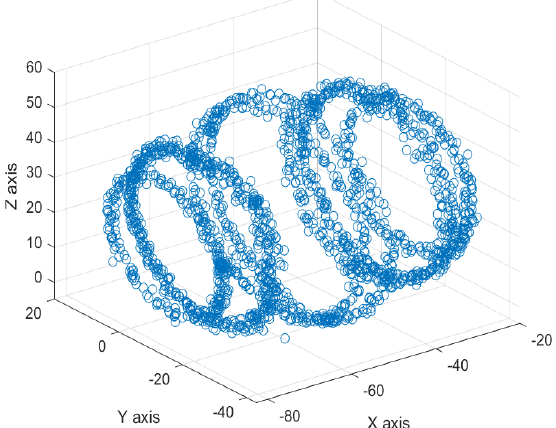
Figure 4. Spatial distribution of initial measurement data.